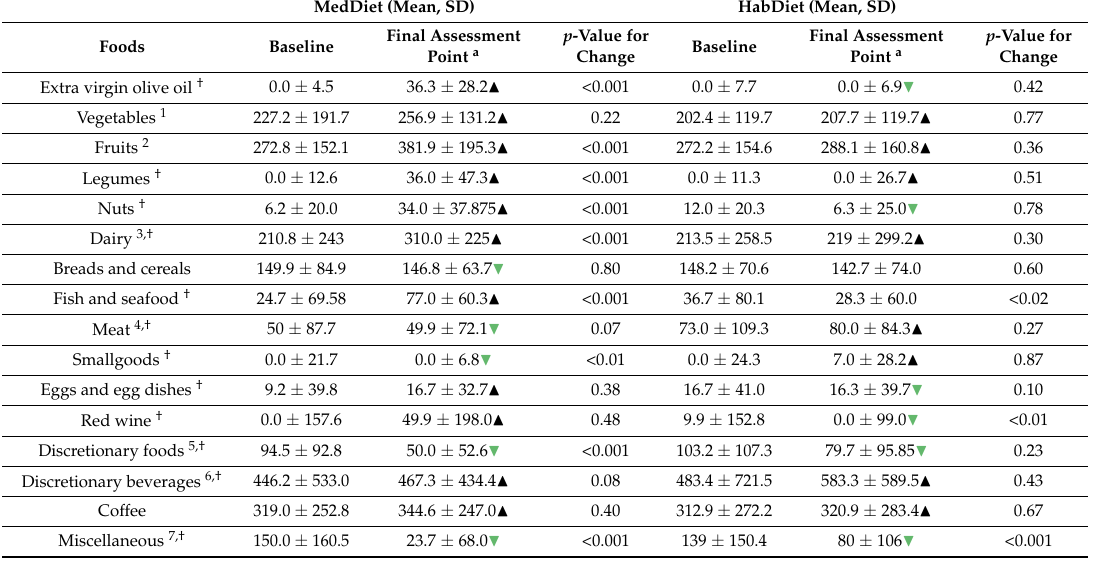
Table 3. Changes in food intake from baseline to the final assessment point observed for the experimental MedDiet group and control HabDiet